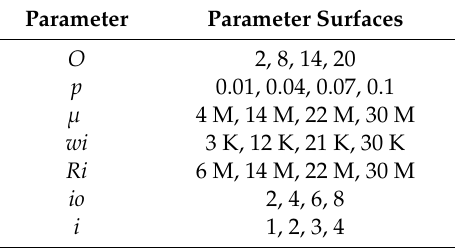
Table 1. Parameter levels.